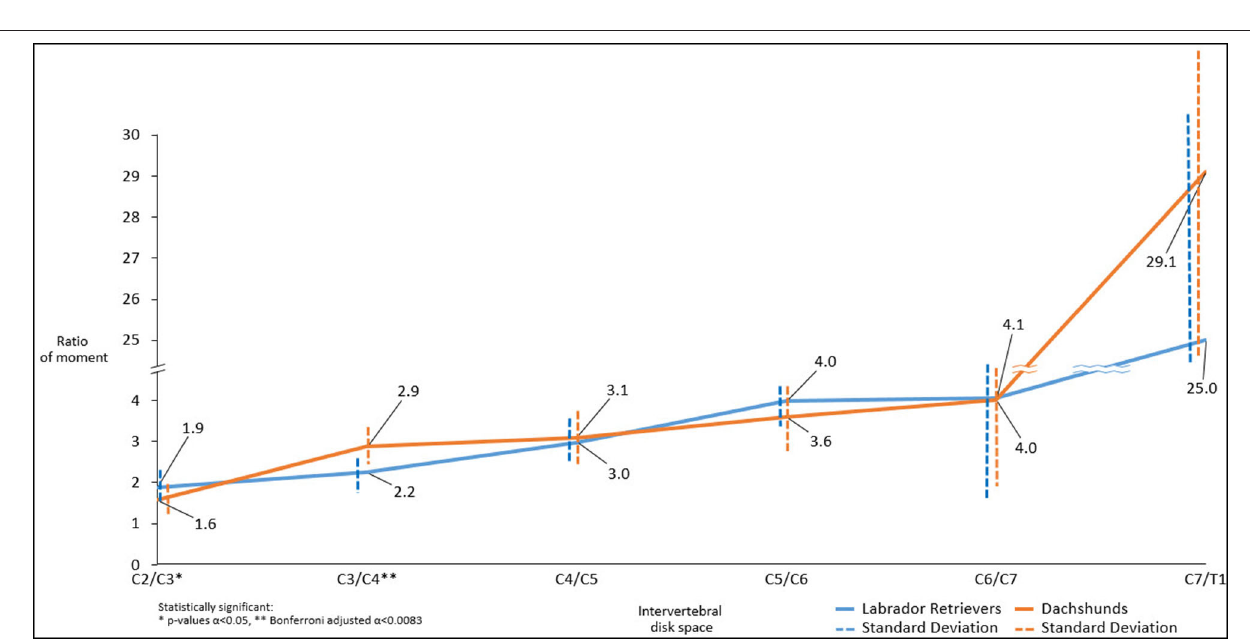
muscle groups to the center of the disk is smaller than the distance from the center of the dorsal muscle group to this same point. This finding might explain a greater tensile strain on the dorsal aspect of the pathologically less resistant AF at this site that would lead to extrusion in cases of disk